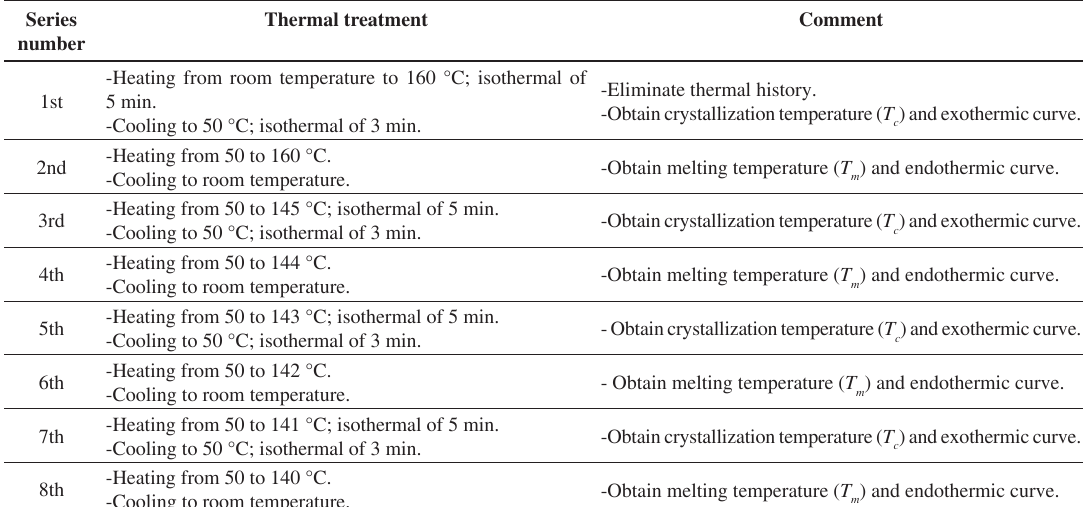
Table 1. DSC experimental conditions used for blend thermal